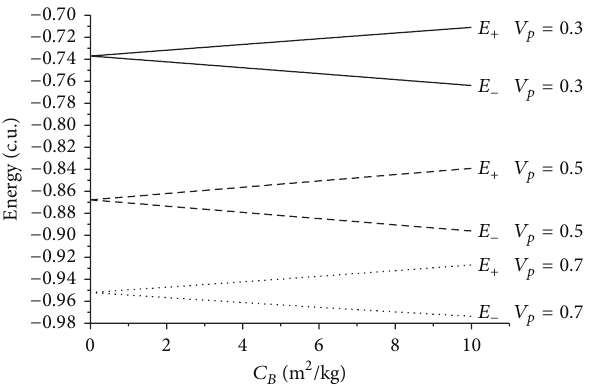
Figure 4: Evolution of the energies as a function of the ballistic coefficients for 𝜓 = 180 ∘ .